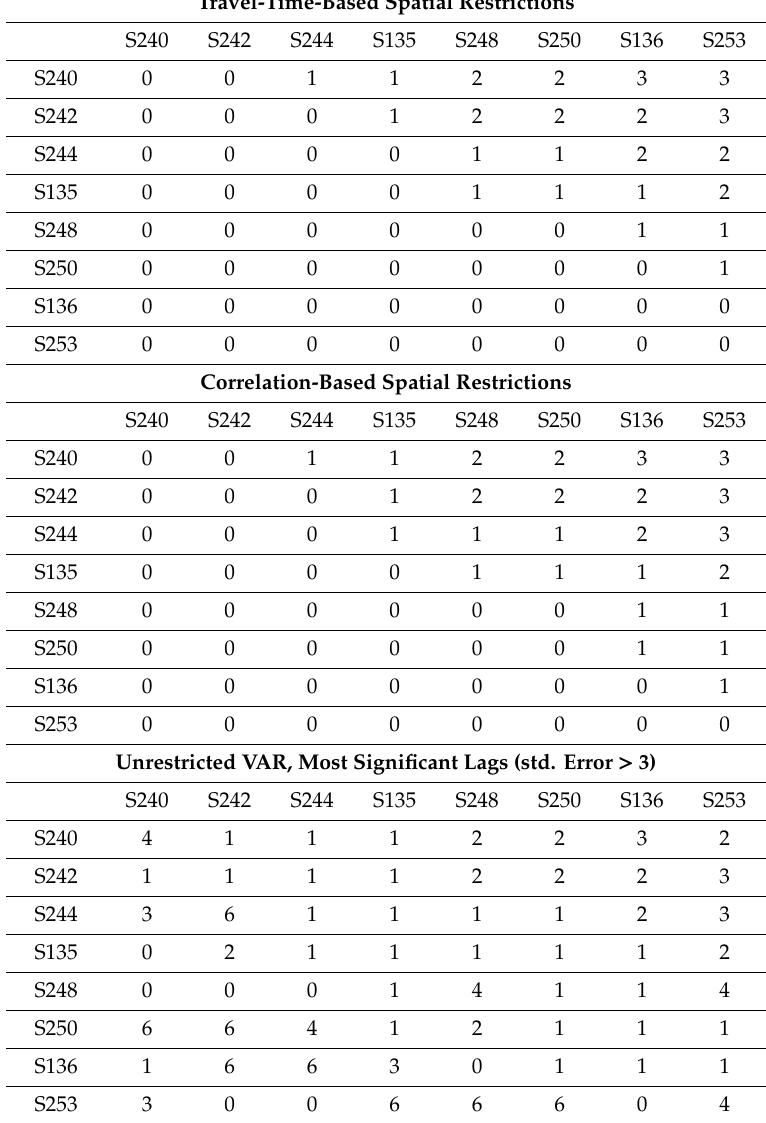
Table 1. Matrices of spatial lags for the original tra ffi c volume in the sequential spatial structure. Travel-Time-Based Spatial